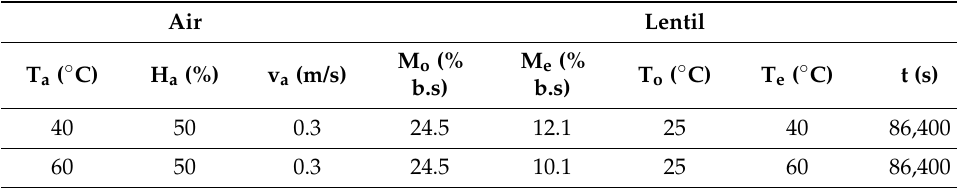
Table 1. Conditions of the drying air and lentil grain